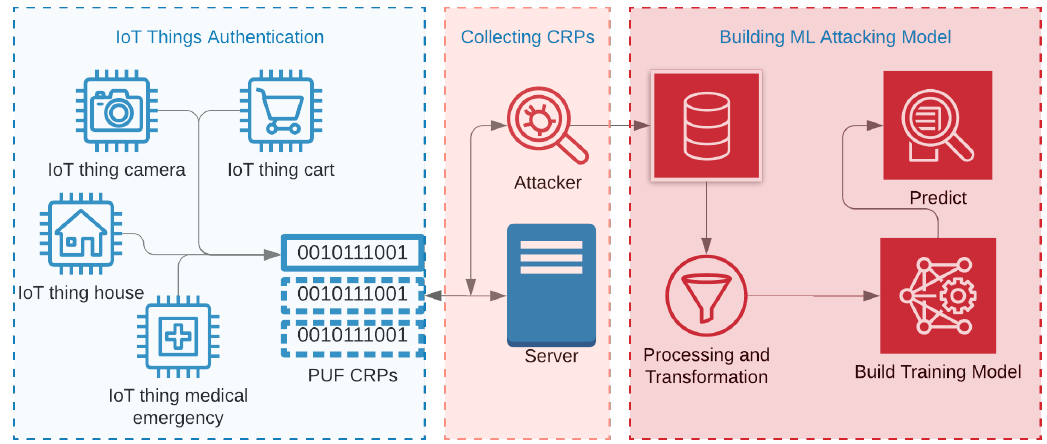
Figure 3. A high-level process of attacking PUFs, which includes collecting Challenge-Response pairs (CRPs) from ongoing authentication between IoT applications and server, preprocessing the gathered CRPs, and building an attacking